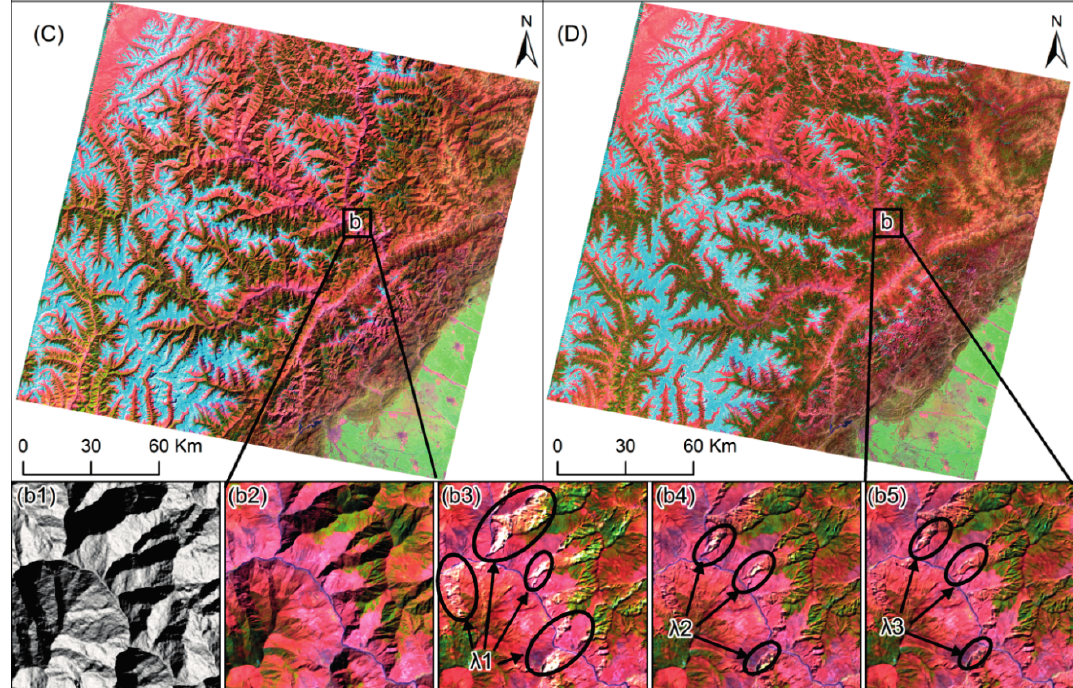
Figure 2. TM scenes before and after topographic correction (composite of band 5, 4 and 3 in red, green and blue), the upper half part is for the autumn scene, and the lower for the spring scene. ( A ) is autumn scene before correction; ( B ) after correction by the proposed model; ( a1 ) is illumination condition map for “sub-scene a”; ( a2 ) is enlarged window for “sub-scene a”; ( a3 – a5 ) are “sub-scene a” corrected by Sandmeier model, Li model and model proposed, respectively; ( C ) is spring scene before correction; ( D ) after correction by the proposed model; ( b1 ) is illumination condition map for “sub-scene b”; ( b2 ) is enlarged window for “sub-scene b”; and ( b3 – b5 ) are “sub-scene b” corrected by Sandmeier